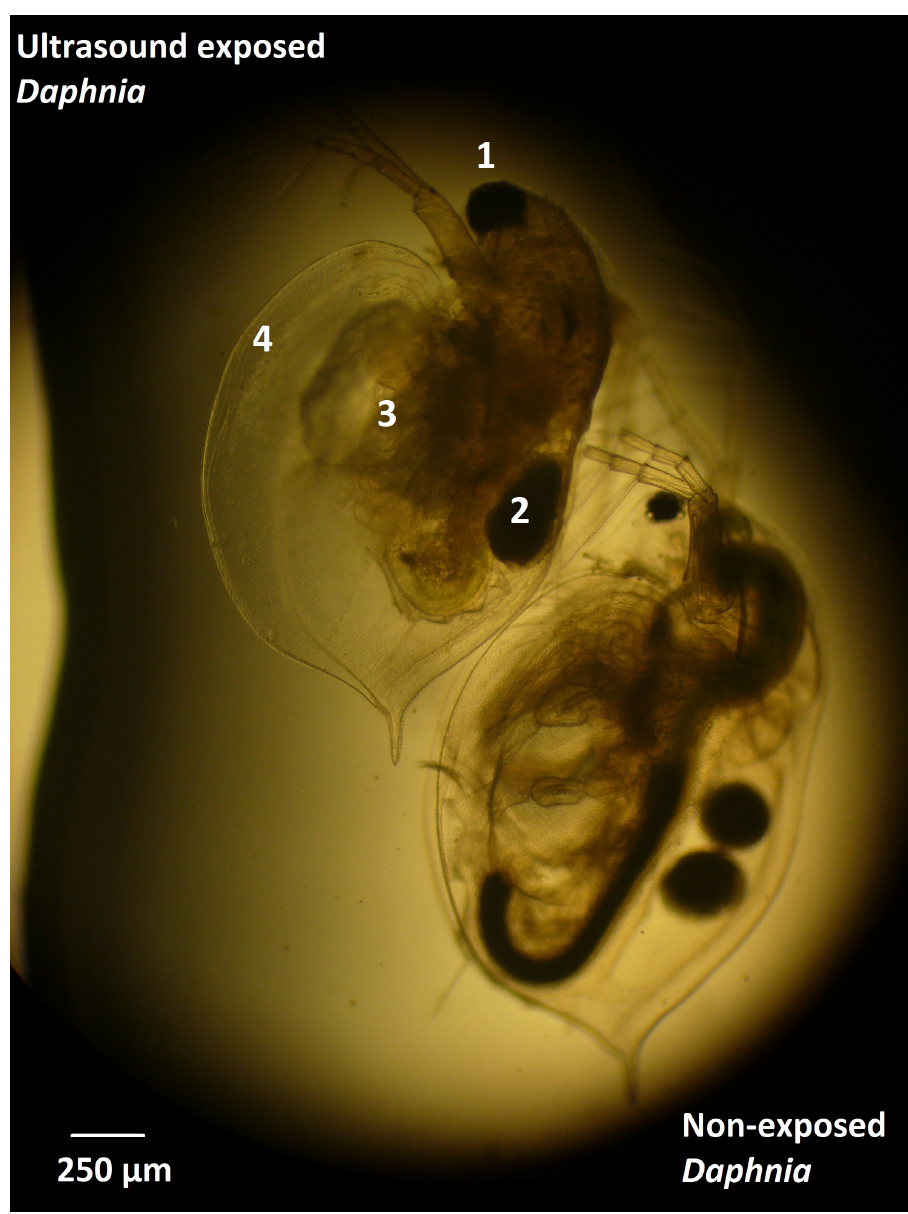
Figure 3. Photograph of an ultrasound (44 kHz) killed Daphnia magna (animal upper left) and a non-exposed specimen from the same cohort (animal right under). 1 = eye, 2 = egg, 3 = intestine, 4 =